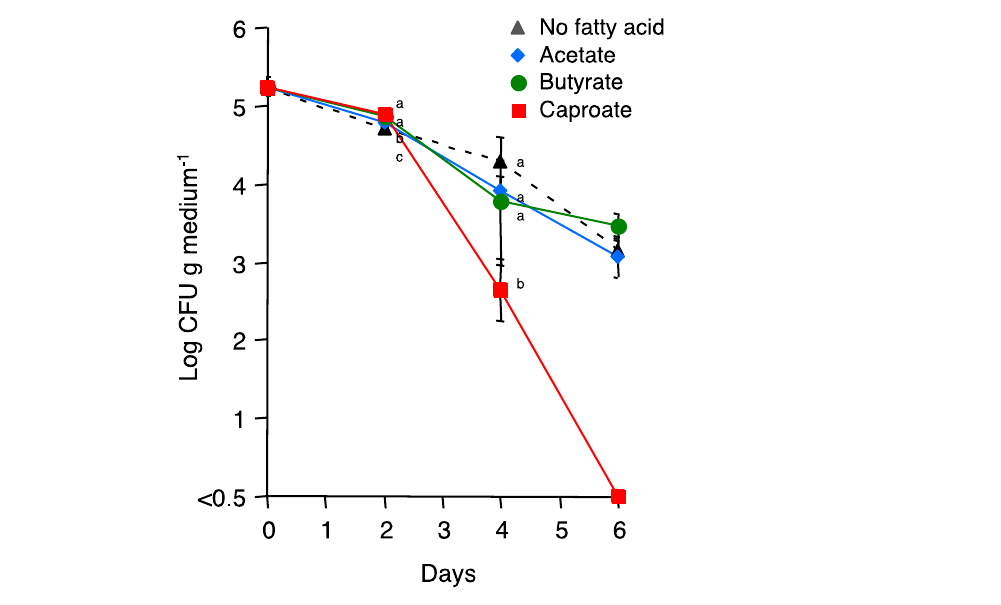
Figure 6. Viable number of Fusarium oxysporum f. sp. lycopersici conidia inoculated into cocopeat medium containing 3 mM each of acetate, butyrate, or caproate. A fatty acid-free control is also shown. Values are expressed as means of Log colony forming unit (CFU) of Fol conidia g medium − 1 ± 1.96 × standard error, when a normal distribution is assumed. Symbols with different alphabets indicate statistically significant differences based on Tukey’s HSD ( α = 0.05).